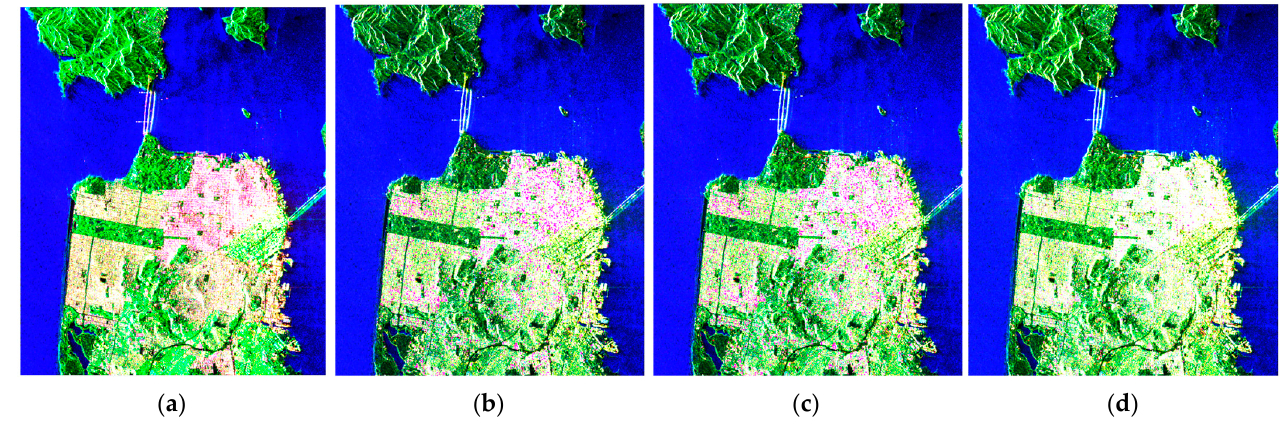
Figure 4. Pseudo-color image of quad-pol data and reconstruction results. ( a ) Quad-pol mode. ( b ) Souyris’ model. ( c ) Nord’s model. ( d ) proposed model.